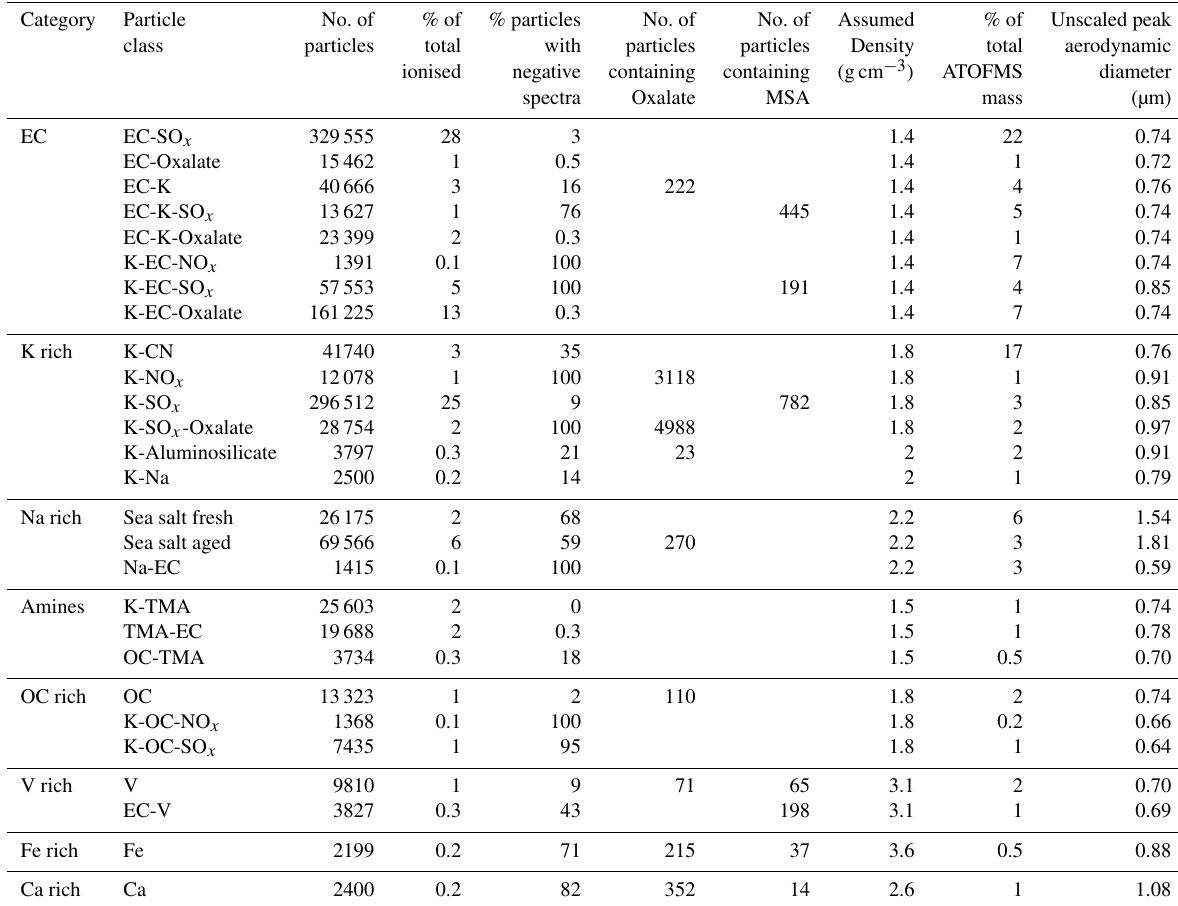
Table 2. Detailed composition of ATOFMS data set during ADRIMED and SAF-MED, by particle classes.